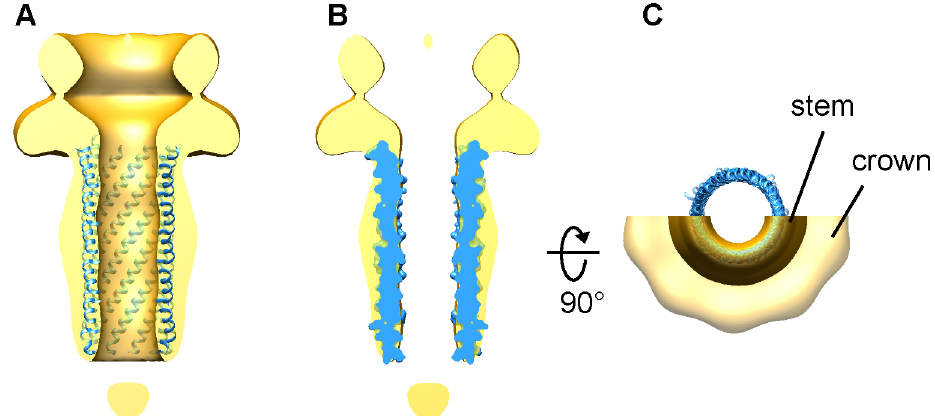
Fig 4. Fitting the phiX174 H protein central domain X-ray structure (blue; RCSB PDB code 4JPP) into the stem domain of the Sf6 gp12 EM map (gold). (A) The H protein structure is shown as ribbon diagram. The front halves of the H structure and the gp12 map were computationally removed for clarity. (B) A corss section of the gp12 map fitted with the H protein structure (molecular surface). (C) A view down the gp12 channel axis. The top half of the gp12 map was removed for clarity. The crown and stem domains of gp12 are